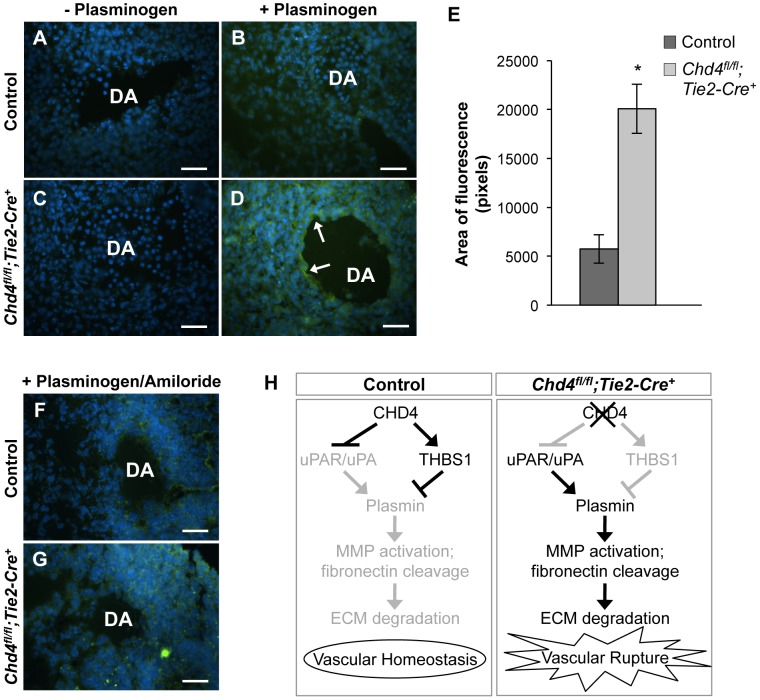
Excessive plasmin activity is detected around rupture-prone Chd4fl/fl;Tie2-Cre+ blood vessels.(A–D) Representative images of E10.5 littermate control (A,B) and Chd4fl/fl;Tie2-Cre+ (C,D) dorsal aortae (DA) subjected to in situ zymography for detection of plasmin activity. Unfixed sections were overlaid with quenched fluorescent casein, a plasmin substrate that fluoresces upon cleavage. In the presence of exogenous plasminogen, casein cleavage (green fluorescence) was substantially higher around Chd4fl/fl;Tie2-Cre+ versus control dorsal aortae (arrows in D versus B). The lack of significant casein cleavage in the absence of exogenous plasminogen (A and C) indicates that the casein cleavage seen in D resulted from plasmin activity. Hoechst (blue) was used for counterstaining. (E) Quantification of three independent in situ zymography experiments such as those shown in B and D from three sets of control and Chd4fl/fl;Tie2-Cre+ embryos. Fluorescence generated by casein cleavage was quantified and measured in pixels, comparing comparably sized control and Chd4fl/fl;Tie2-Cre+ dorsal aortae. Data are presented as mean ± SD. (F–G) In situ zymography for plasmin activity was performed as described in A for control and Chd4fl/fl;Tie2-Cre+ embryonic sections in the presence of the uPA inhibitor amiloride. Amiloride decreased the level of plasmin activity surrounding the Chd4fl/fl;Tie2-Cre+ DA (G) to that seen surrounding the control DA (F). (H) Model for how CHD4 impacts ECM proteolysis and vascular integrity through transcriptional regulation of Thbs1 and Plaur. (Left panel) In control endothelial cells, plasmin production and ECM degradation are curbed by CHD4-mediated inhibition of the genes encoding uPA/uPAR and activation of the gene encoding THBS1, resulting in vascular homeostasis. (Right panel) In Chd4fl/fl;Tie2-Cre+ endothelial cells, loss of CHD4 leads to increased plasmin activation, which enhances MMP activation and fibronectin cleavage. The net result is excessive ECM degradation and vascular rupture. Scale bars: 100 µm.